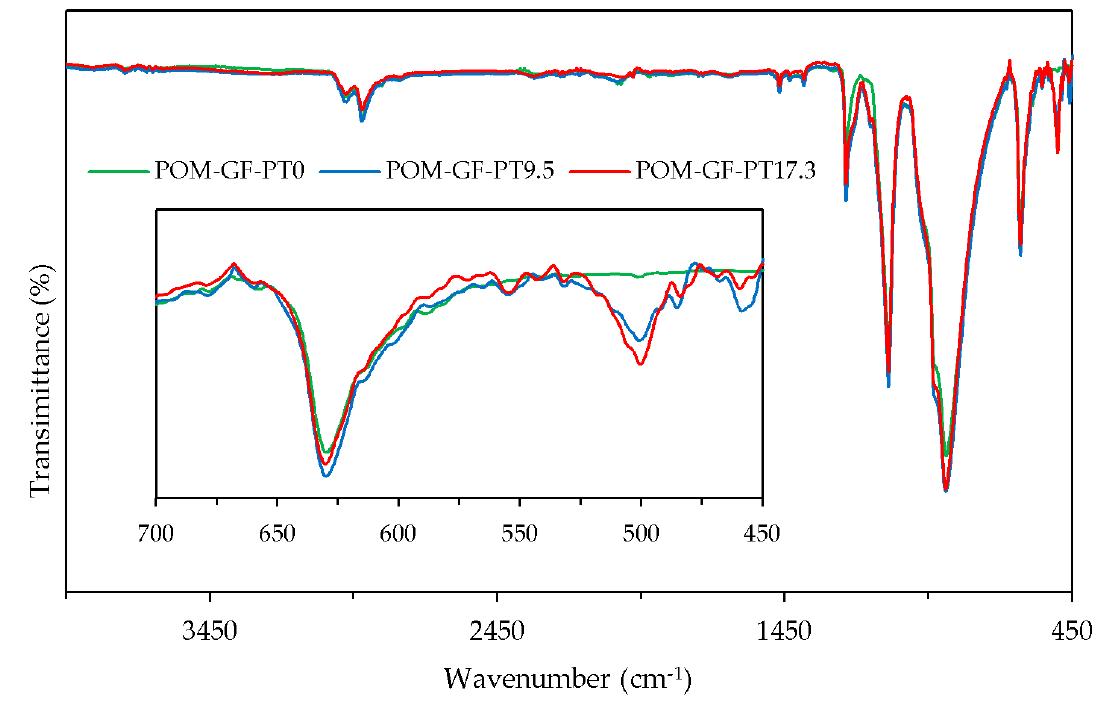
Figure 7. Fourier transform infra-red (FTIR) transmittance of POM/GF/PTFE composites blended with 0%, 9.5% and 17.3% PTFE micro-particles.